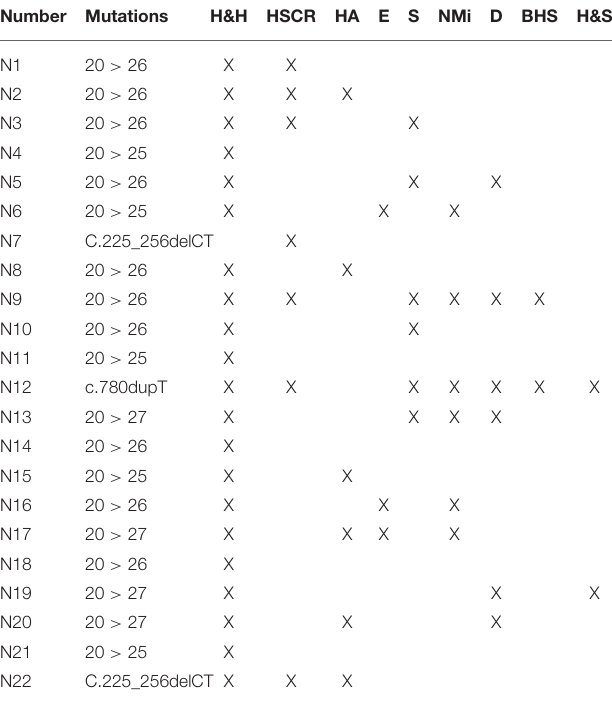
TABLE 3 | Genotype and phenotype features of our patients with CCHS. Number